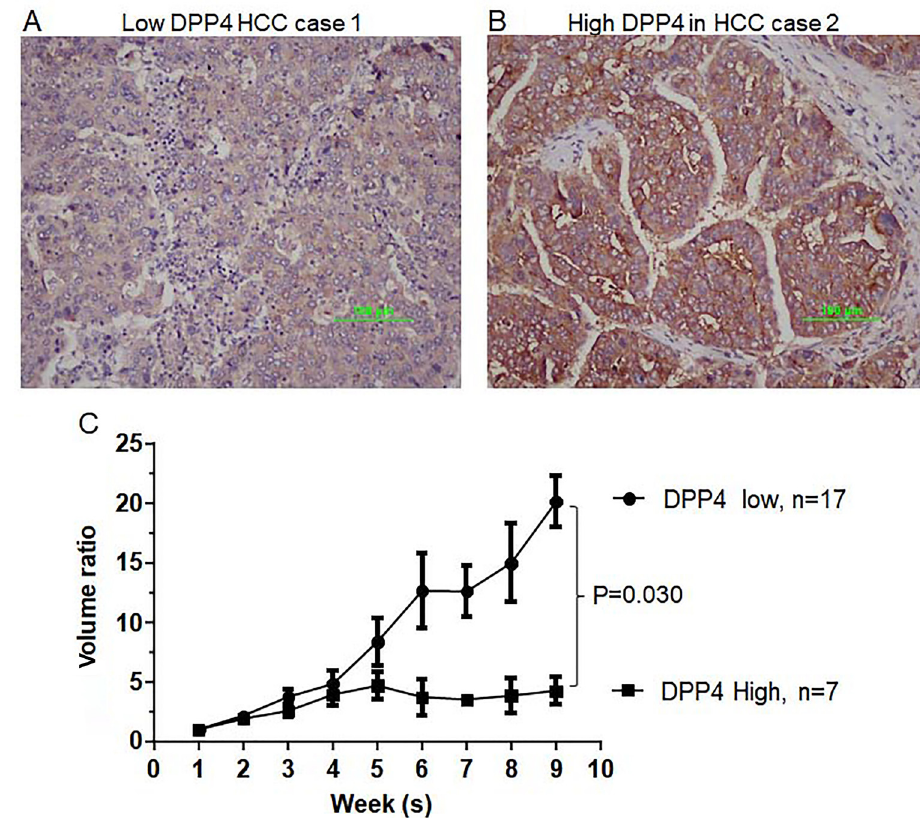
Figure 4. Photomicrographs of hepatocellular carcinoma (HCC) tissues with ( A ) low and ( B ) high expression of dipeptidyl peptidase 4 (DPP4) ( (cid:1) 100, scale bar 100 m m). Tumor growth curves of HCC patient-derived xenograft models for low and high DPP4 expression groups ( C ). Data are reported as